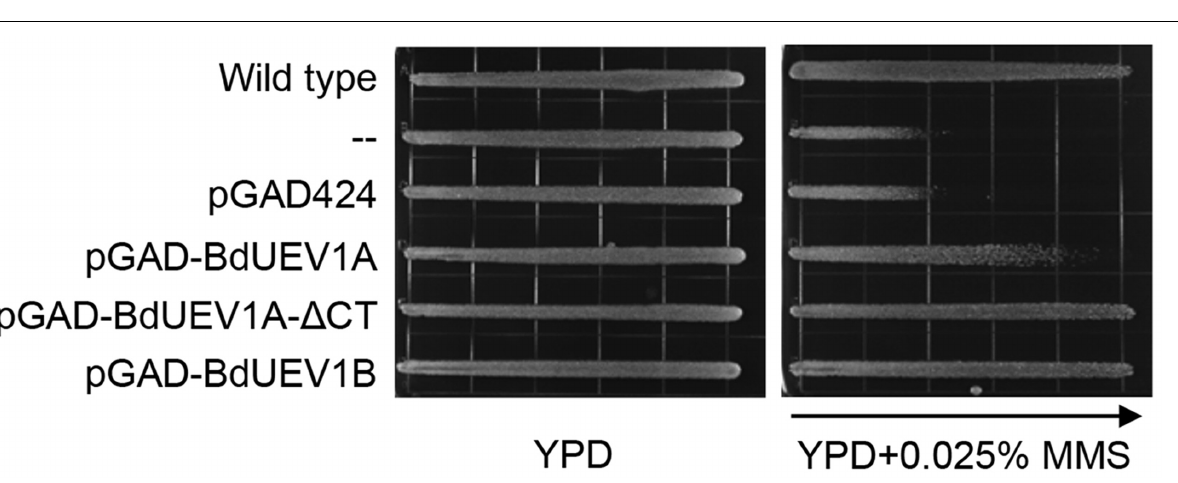
FIGURE 6 | The C-terminal tail of BdUev1A affects functional complementation of the yeast mms2 null mutant. mms2 null mutant (WXY942) transformants with plasmids expressing BdUev1A, BdUev1A- (cid:49) CT or BdUev1B were assessed by an MMS gradient plate assay. The plates were incubated at 30 ◦ C for 3 days. Arrow points to gradually increasing MMS